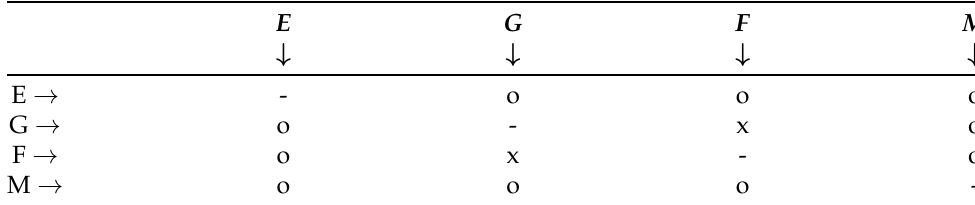
Table 1. Matrix of reciprocal independence of the performance indexes. o—no dependence, x— possible